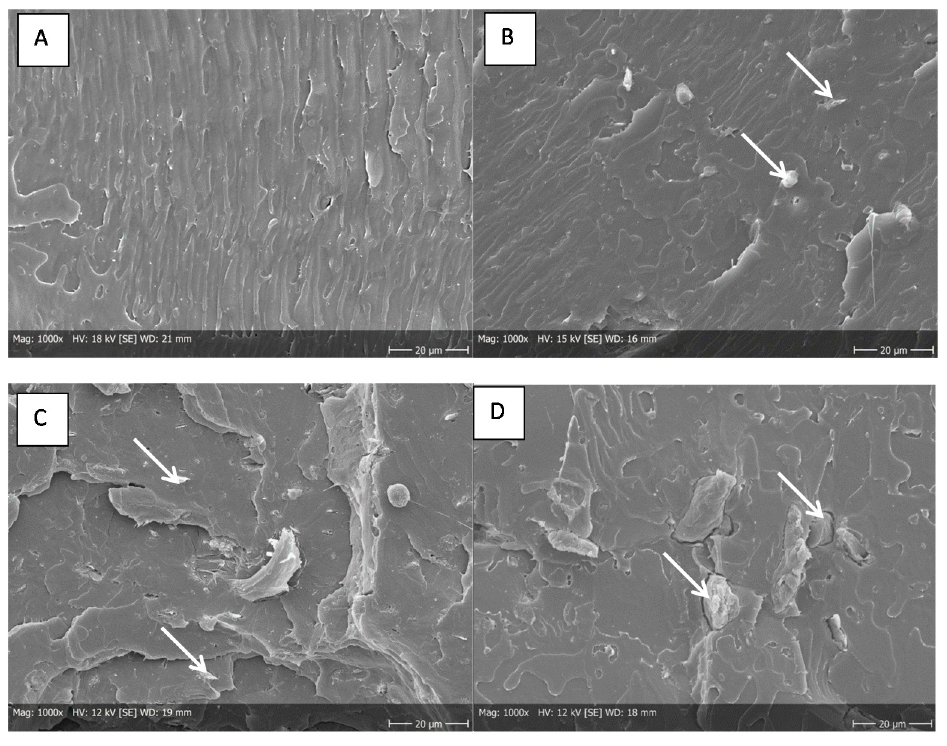
Figure 4. SEM image of injection molded test bars. ( A ) PLA matrix, ( B ) PLA with CNF, ( C ) PLA with HefCel CMF and ( D ) PLA with MC. Arrows are indicating fibers.